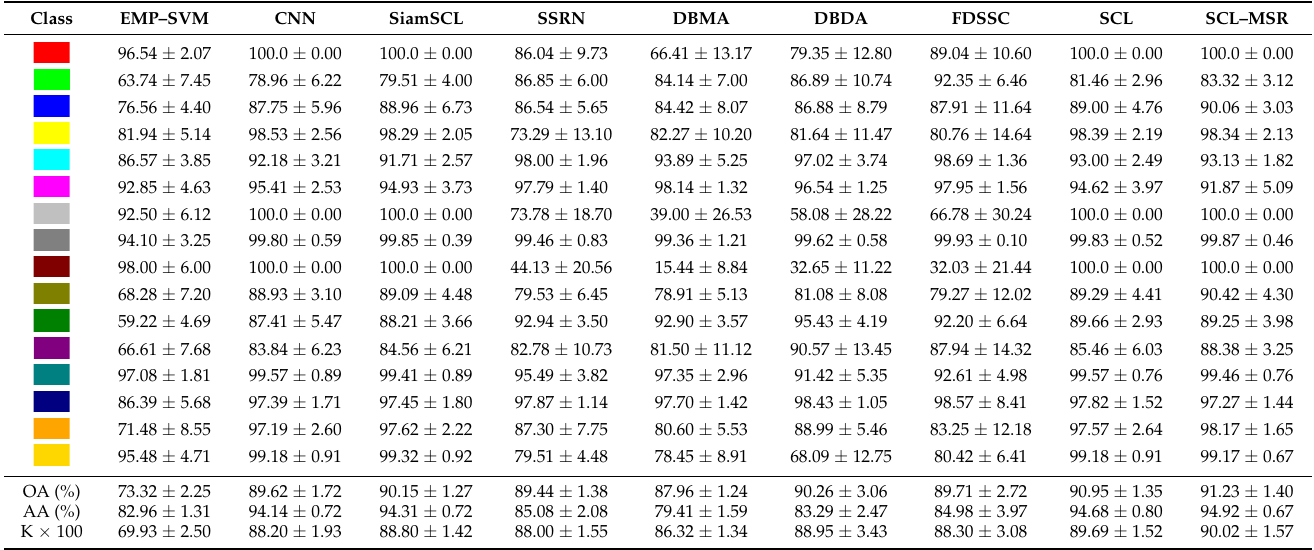
Table 6. Testing data classification results (mean ± standard deviation) on the Indian Pines dataset.